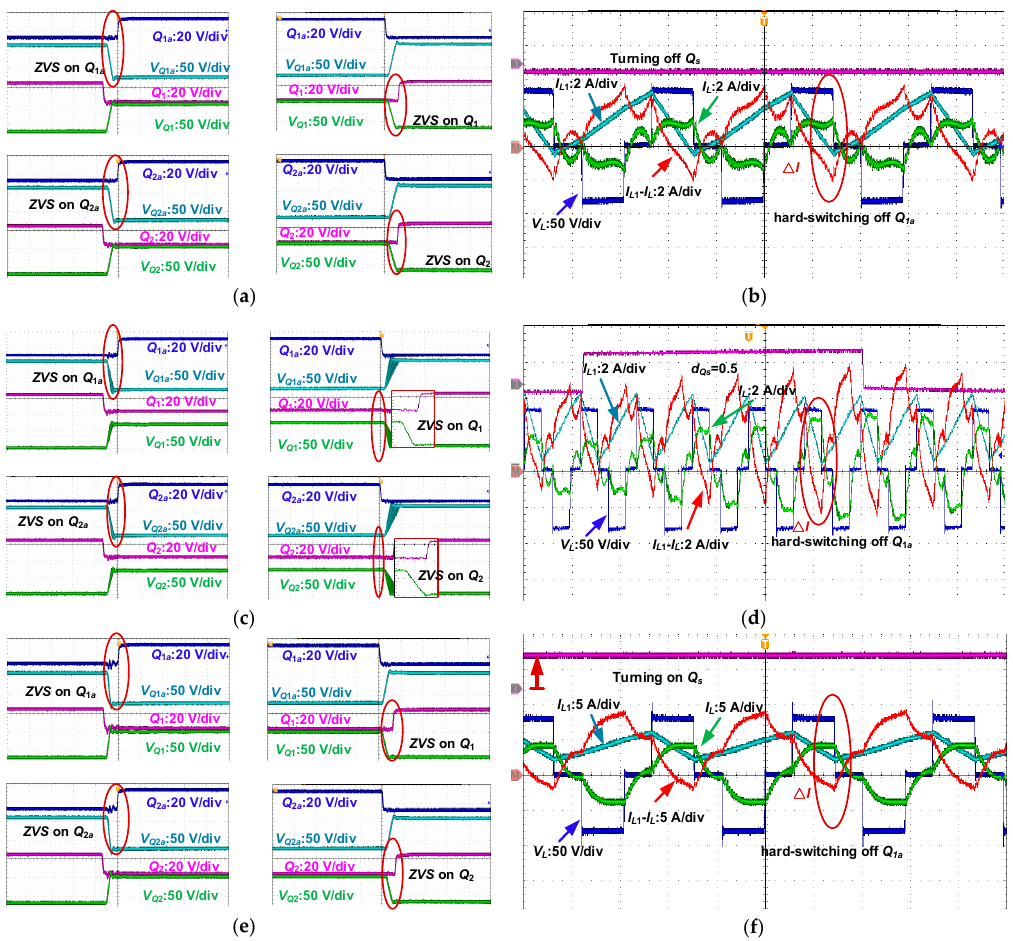
Figure 15. ZVS waveforms under different cases: ( a ) ZVS of four switches when d Qs = 0; ( b ) current waveforms when d Qs = 0; ( c ) ZVS of four switches when d Qs = 0.5; ( d ) current waveforms when d Qs = 0.5 ( e ) ZVS of four switches when d Qs = 1; ( f ) current waveforms when d Qs = 1.